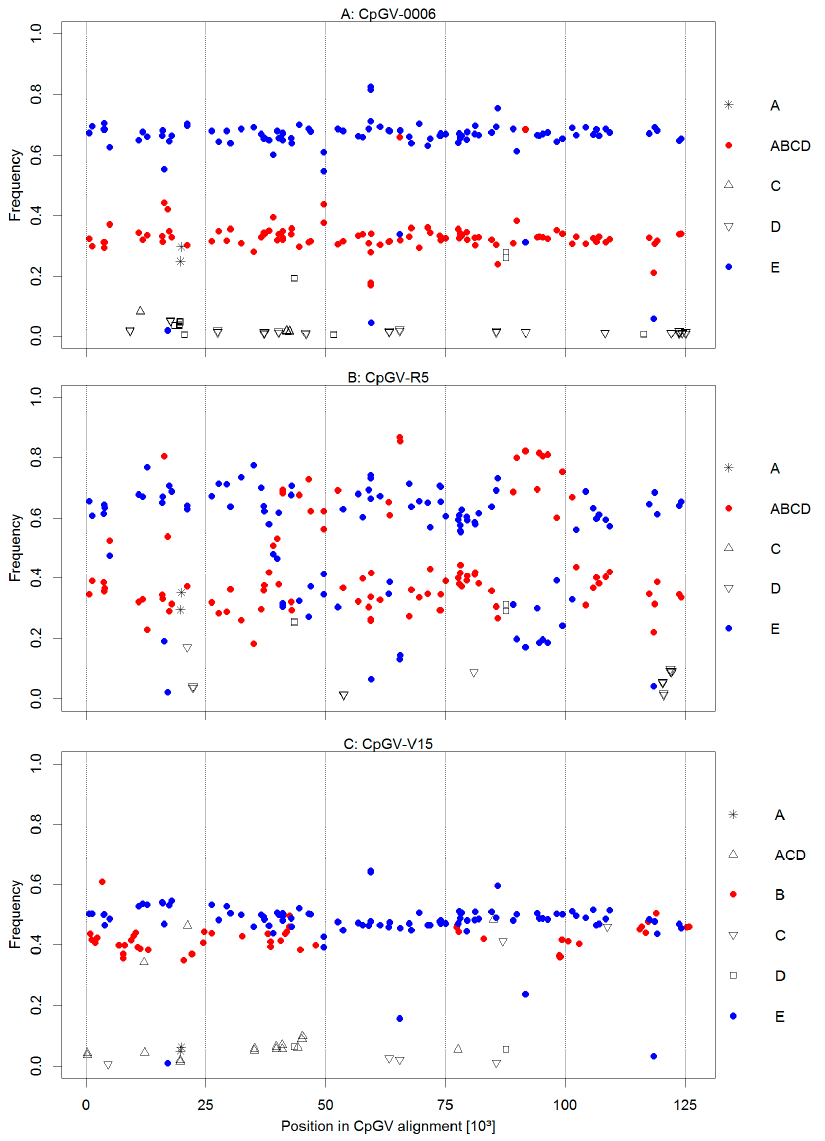
Figure 4. Frequencies of SNP variants specific for one of the CpGV genome types (A, B, C, D, E) or the combination ABCD (complement to E) in CpGV-0006 ( A ); CpGV-R5 ( B ) and CpGV-V15 ( C ) according to their nucleotide position in the CpGV consensus sequence. Blue: genome type E in CpGV-0006, -R5 and -V15; red: genome type A in CpGV-0006 and -R5, as well as genome type B in CpGV-V15; open symbols: other genome groups as indicated.